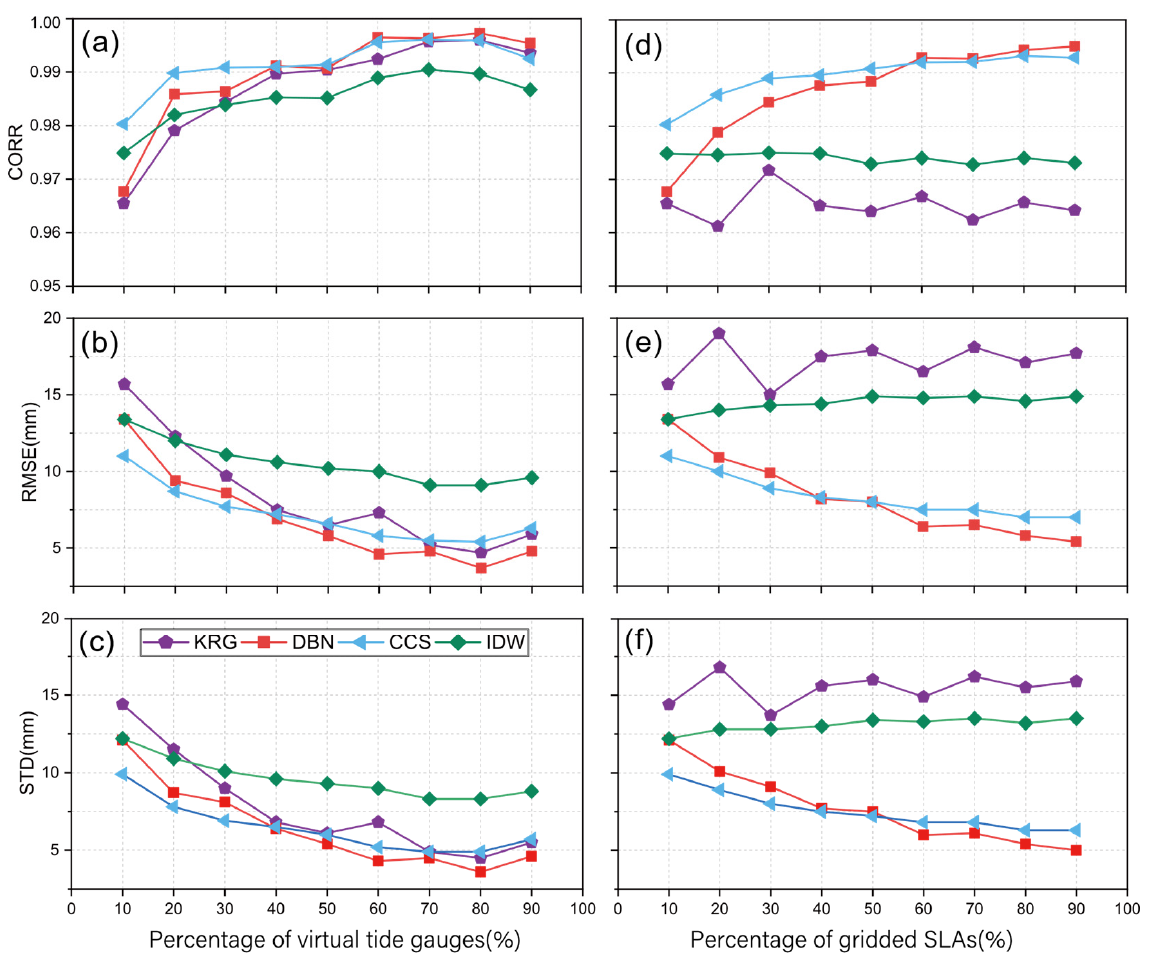
Figure 4. The correlation coefficients (a, d) , RMSE (b, e) and STD (c, f) of the four methods with virtual tide gauges.